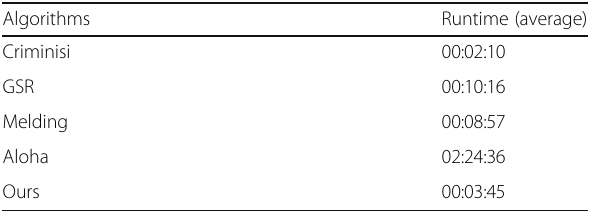
Table 1 Comparison of mean run time in HH:MM:SS for 30